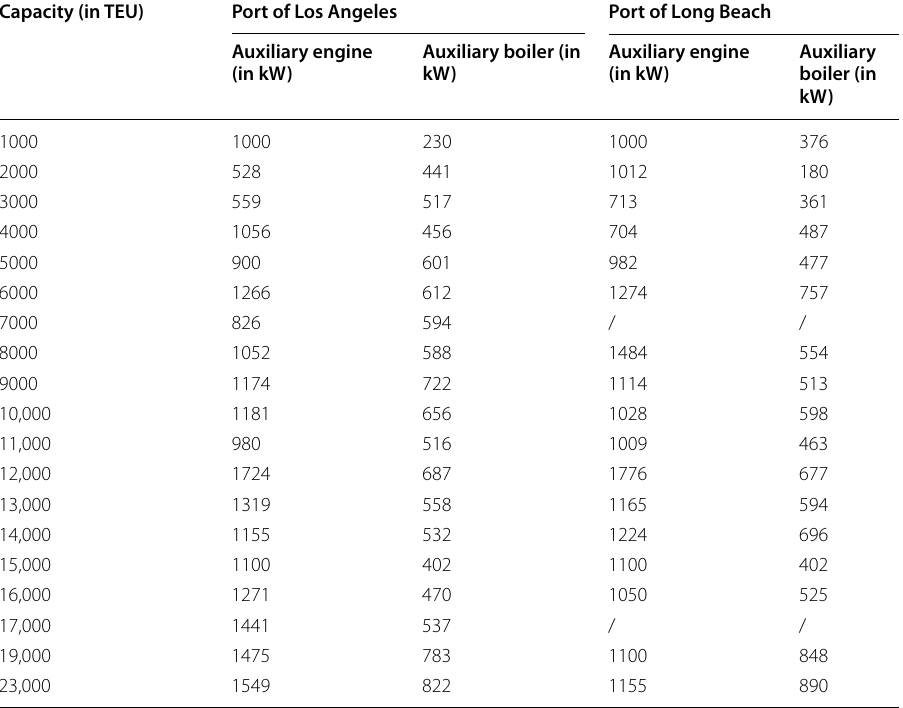
Table 2 Average auxiliary engine and boiler load defaults for ships at anchorage in the Port of Los Angeles (2020) and the Port of Long Beach. Source : Starcrest 2021a;